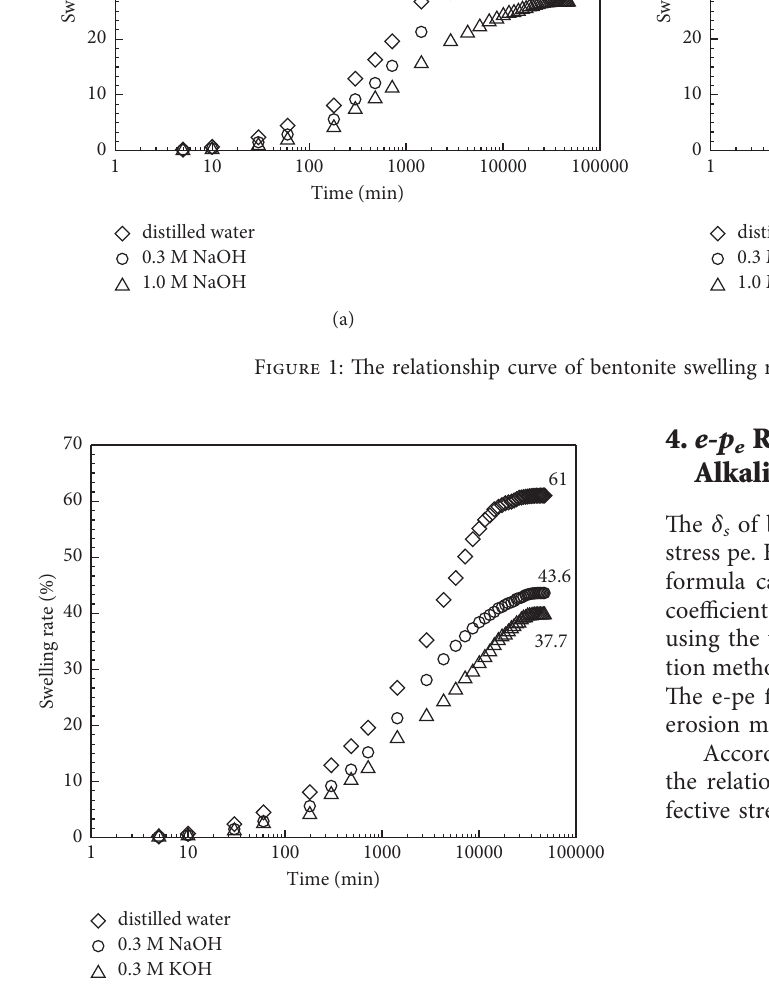
Figure 2: The swelling rate of different solutions varies with time at